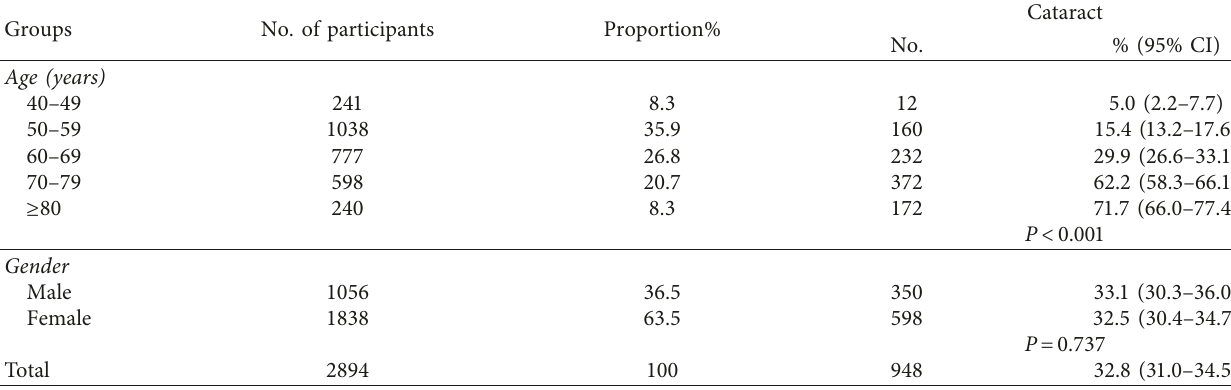
Table 2: Prevalence of cataract stratified by age and gender in the Jingan district of Shanghai in 2010. Groups No. of participants